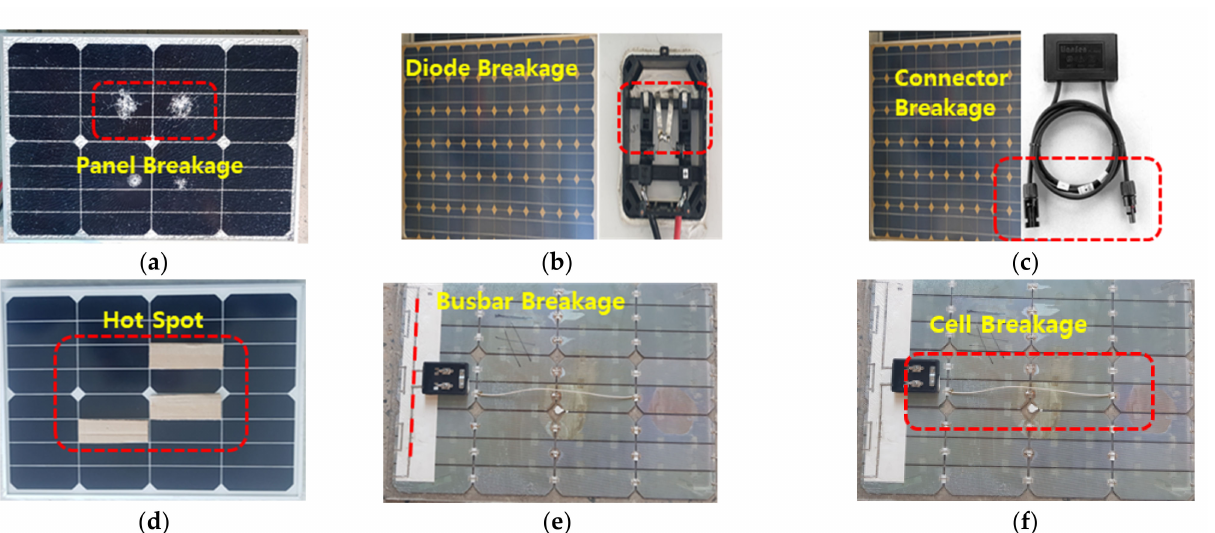
Figure 2. Photographs of PV panels with different failure types: ( a ) panel breakage, ( b ) diode failure, ( c ) connector breakage, ( d ) hotspot, ( e ) busbar, and ( f ) overheating of panel